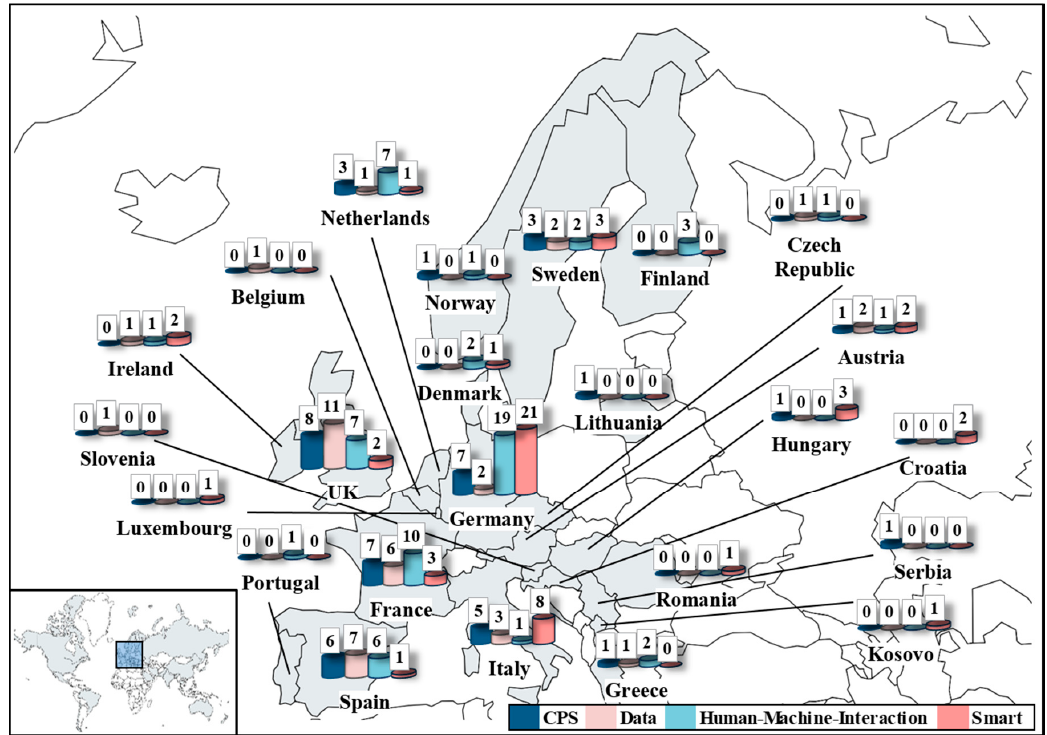
Figure 4. Papers identified in the uncorrelated international analysis (European scale). Sources of the shapefile: [38,39].